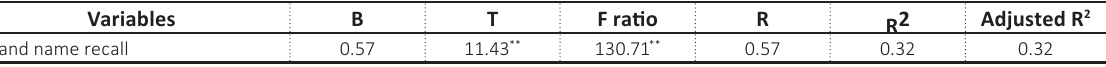
Table 4. Regression analysis of the predictability of brand name recall by Web Series watched